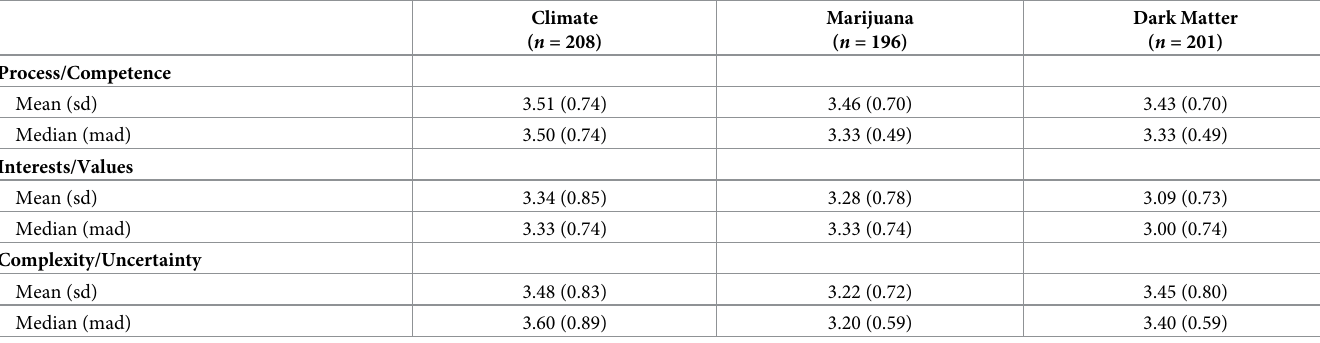
Table 2. Study 1. Science Dispute Reason descriptive statistics by